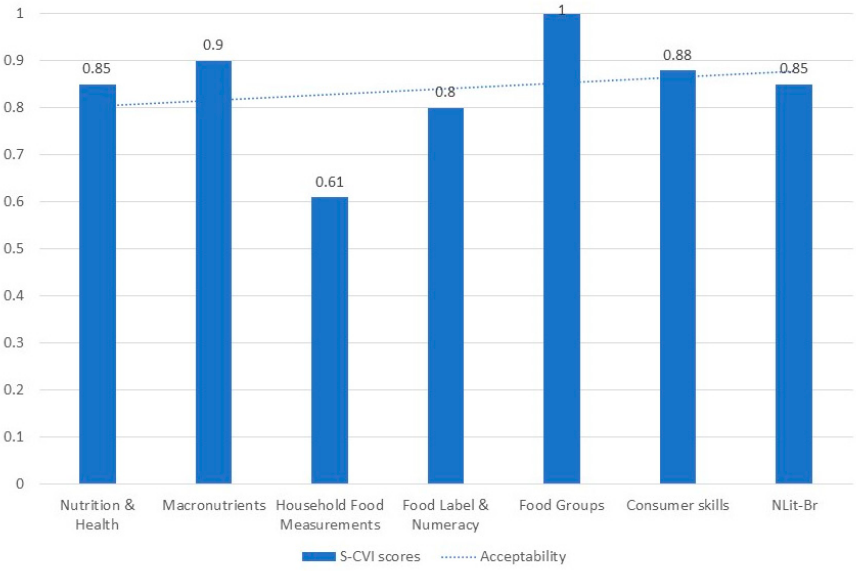
Figure 1. Nutrition experts’ agreement scores on the Nutrition Literacy Assessment Instrument in Brazilian Portuguese ( n = 6).